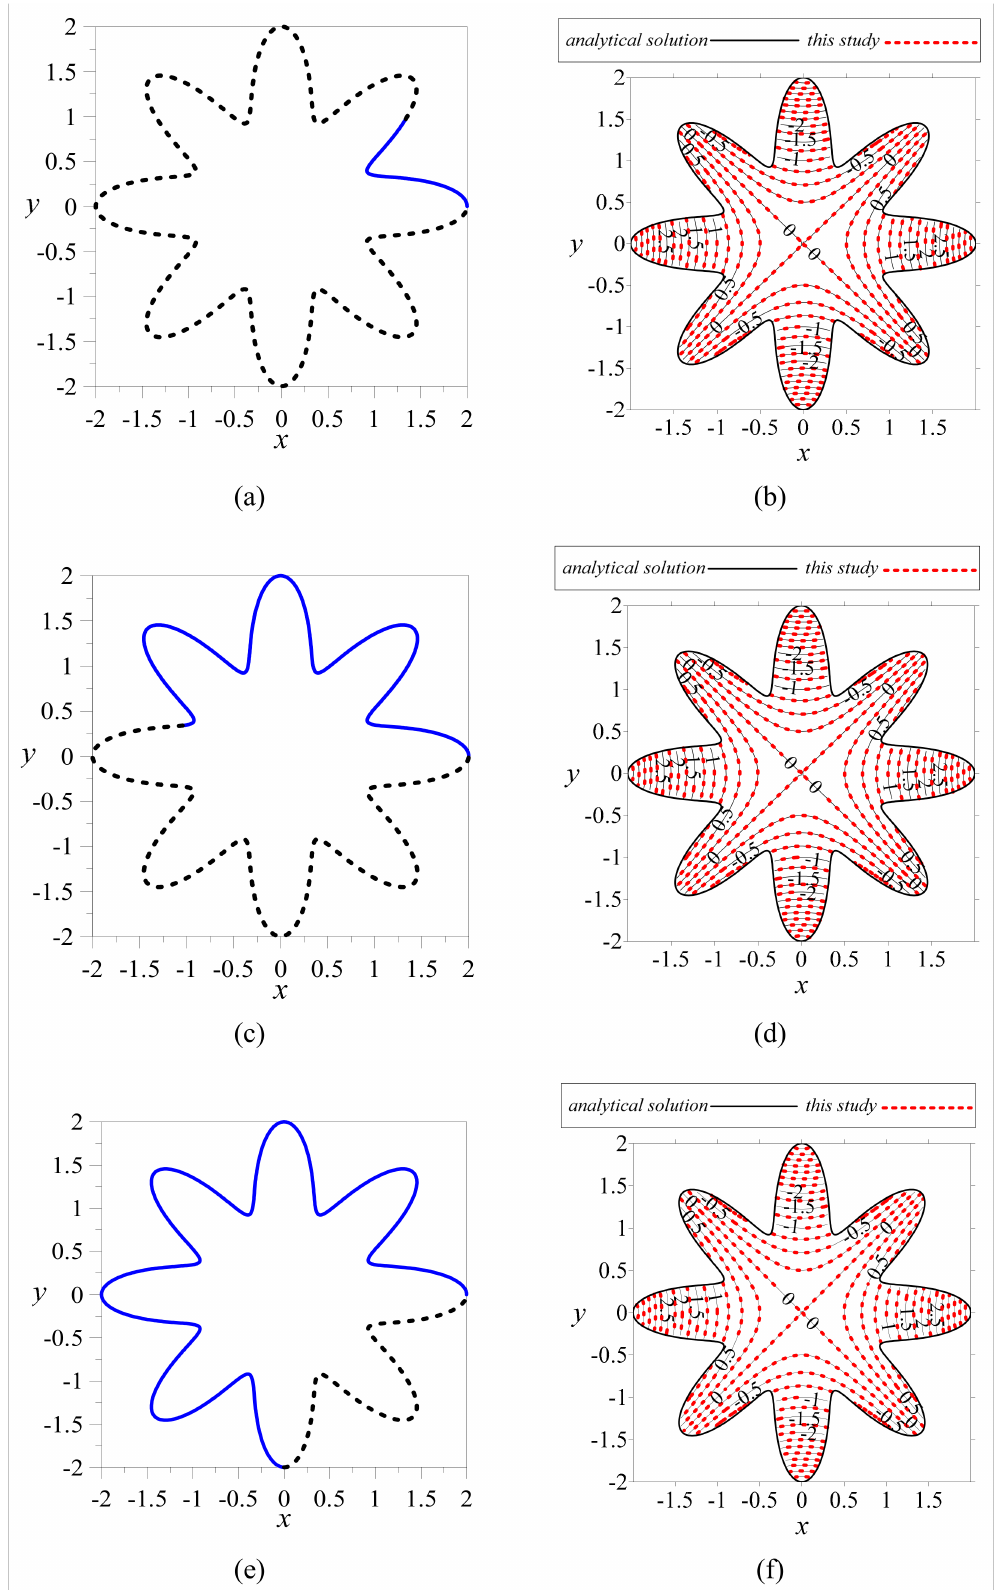
Figure 13. Comparison of the temperature fields of the multiple source meshless method. ( a,c,e ) Over-specified boundary conditions are given on the 2 / 20, 9 / 20, and 15 / 20 portion of the overall boundary, ( b ) results comparison with boundary data of θ values in the range of 0 ≤ θ ≤ 0.2 π , ( d ) results comparison with boundary data of θ values in the range of 0 ≤ θ ≤ 0.9 π , and ( f ) results comparison with boundary data of θ values in the range of 0 ≤ θ ≤ 1.5